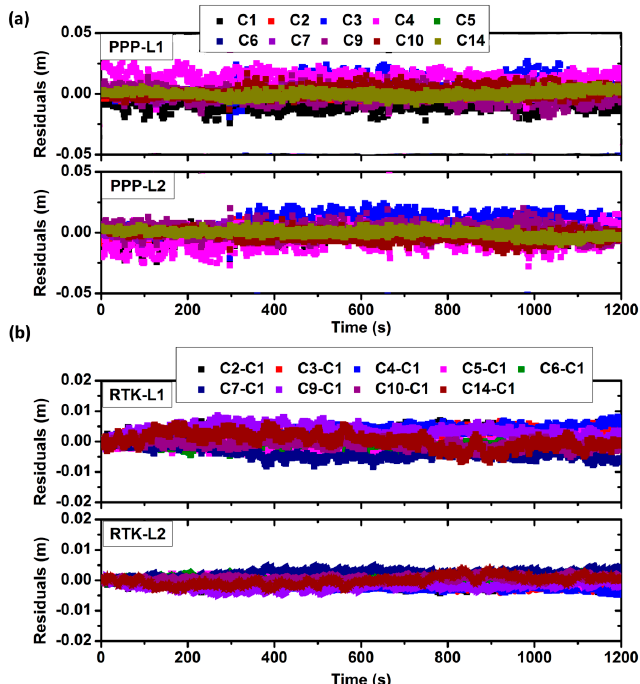
Figure 5. The comparison of observation residuals. ( a ) The residuals of the L1 and L2-frequency carrier phase observations by PPP mode; ( b ) The residuals of the L1 and L2-frequency carrier phase observations by URTK mode.